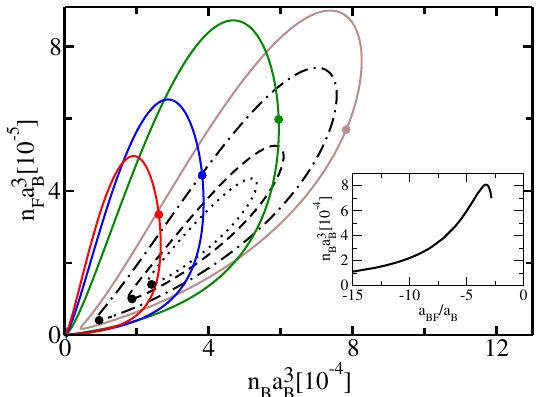
− n plane. B F / a = − 2.45(dotted), BF B